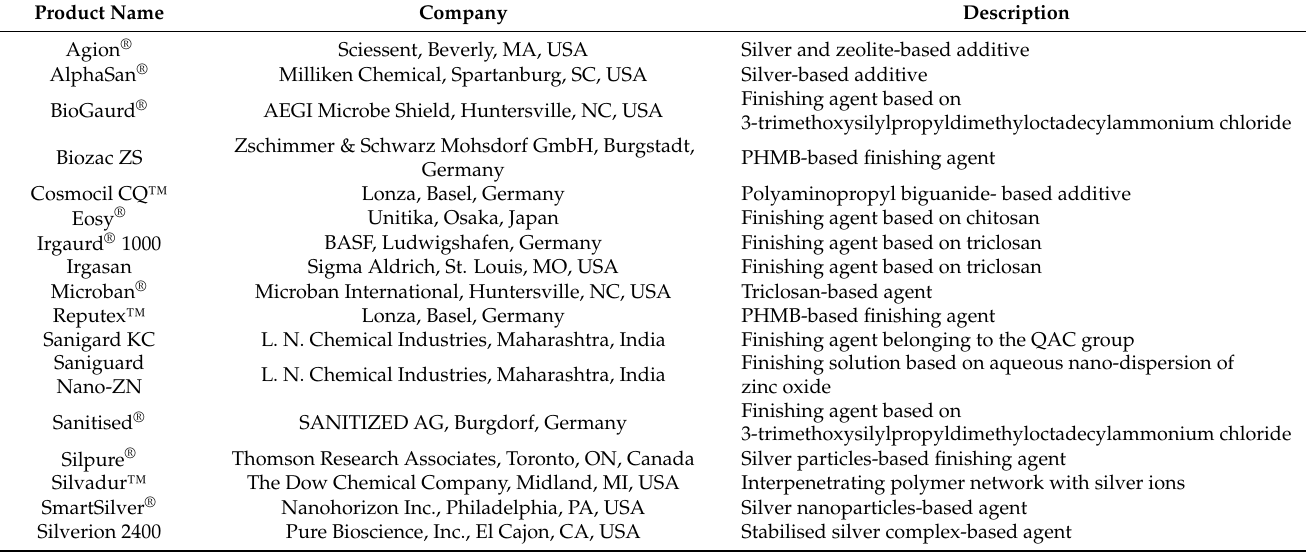
Table 3. Representation of commercially available antimicrobial agents on the market